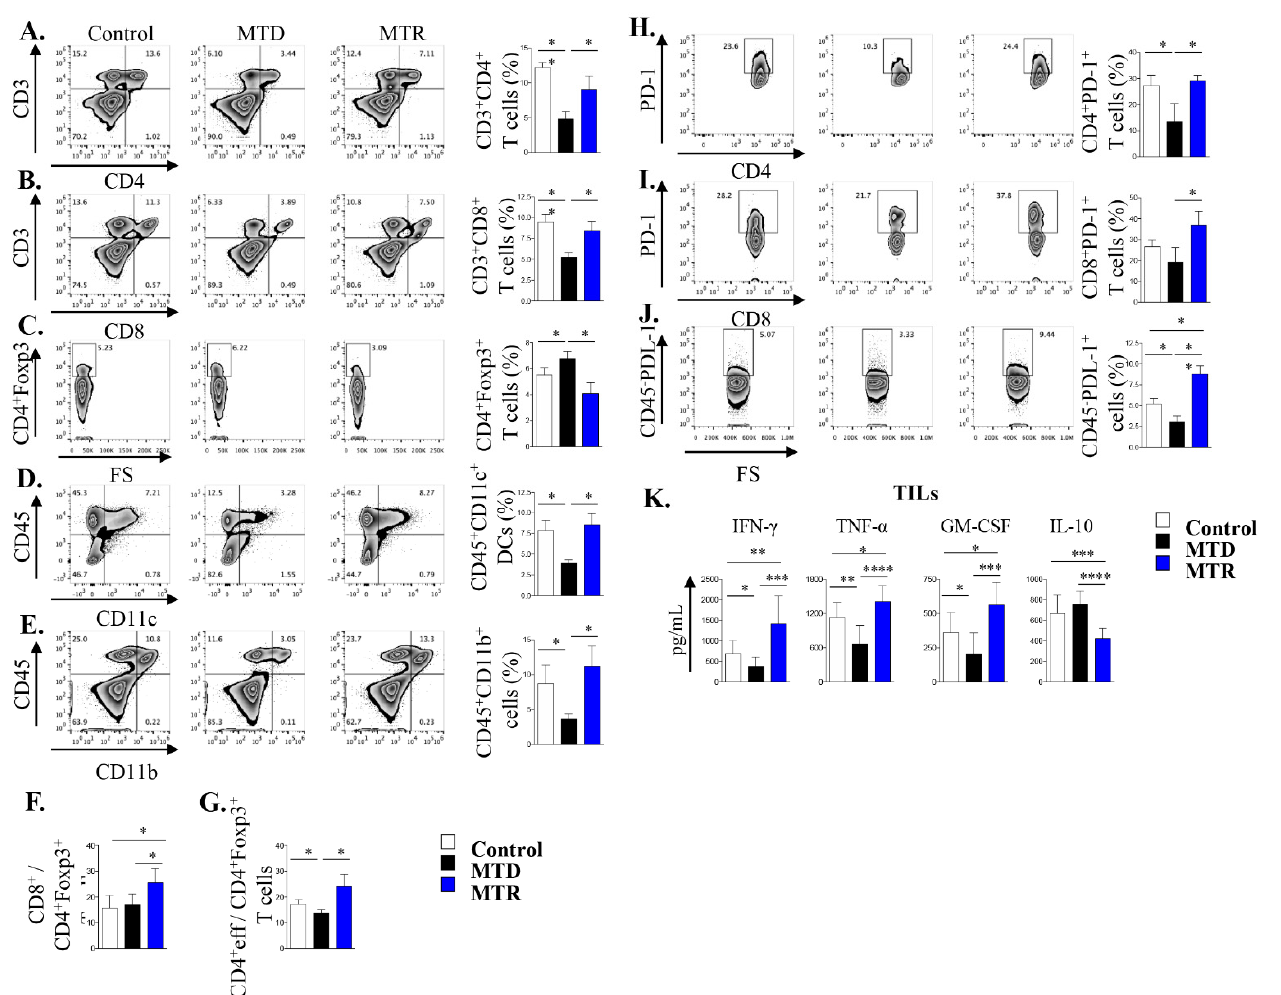
Figure 6. Immune cell composition in the tumor microenvironment upon MTD and MTR administration in a syngeneic lung tumor mouse model. A. Representative FACS plots showing the percentages of CD3 + CD4 + T cells ( A ), CD3 + CD8 + T cells ( B ), CD4 + Foxp3 + Treg cells ( C ), CD45 + CD11c + DCs ( D ) and CD45 + CD11b + myeloid cells ( E ) among lung TILs isolated from LLC-OVA inoculated control-, MTD- and MTR-treated mice. Cumulative data, shown as mean ± SD, are depicted on the right. ( F ) The ratios of CD8 + /CD4 + Foxp3 + T cells and CD4 + eff/CD4 + Foxp3 + T cells ( G ) are depicted. ( H ) The percentages of CD4 + PD-1 + T cells and CD8 + PD-1 + T cells ( I ) are shown. ( J ) The percentages of CD45 − PD-L-1 + cells are shown. Data for A-J are pooled from n = 6–8 mice/group from 3 independent experiments. ( K ) IFN- γ , TNF- α , Granulocyte-macrophage colony-stimulating factor (GM-CSF) and IL-10 levels in culture supernatants of TILs re-stimulated ex vivo with Ova are shown. Data are mean ± SD of triplicate wells. Statistical analysis was performed by Student’s t -test; * p < 0.05, ** p < 0.01, *** p < 0.001 and **** p < 0.0001.